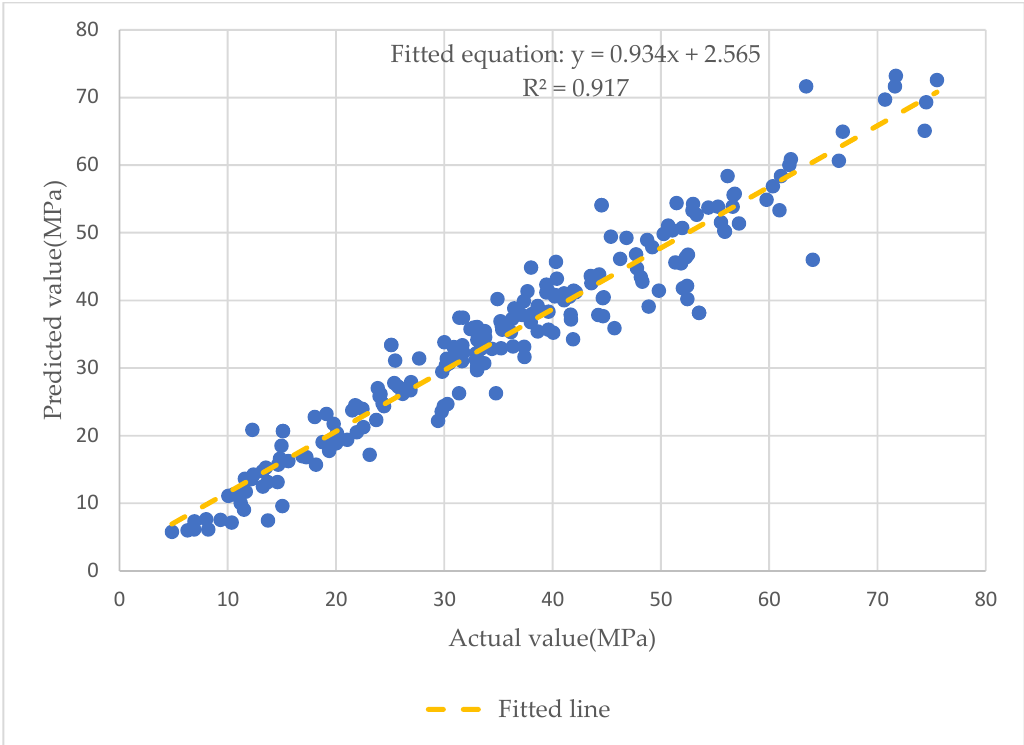
Figure 14. Relationship between tested and predicted compressive strength in the test set.